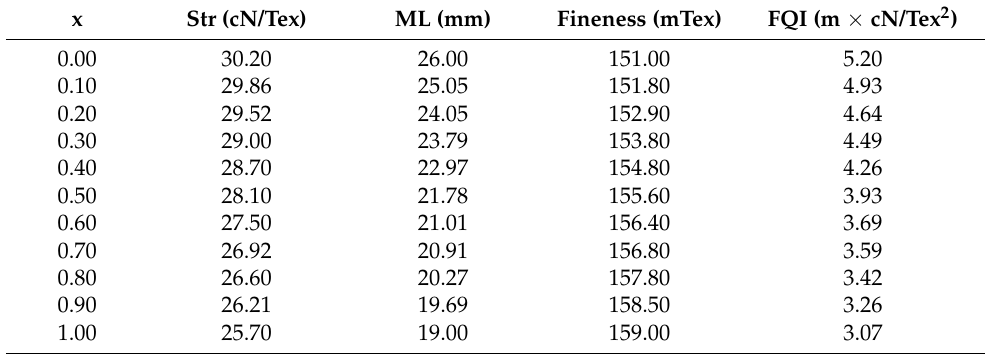
Table 3. FQI for the V1 and W2 blend.